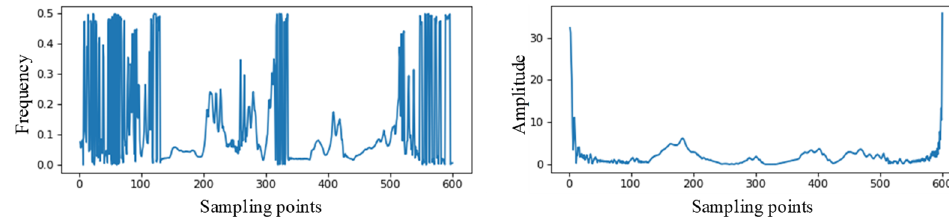
Figure 9. Instantaneous frequency and instantaneous amplitude of intrinsic mode function 1 (IMF1).